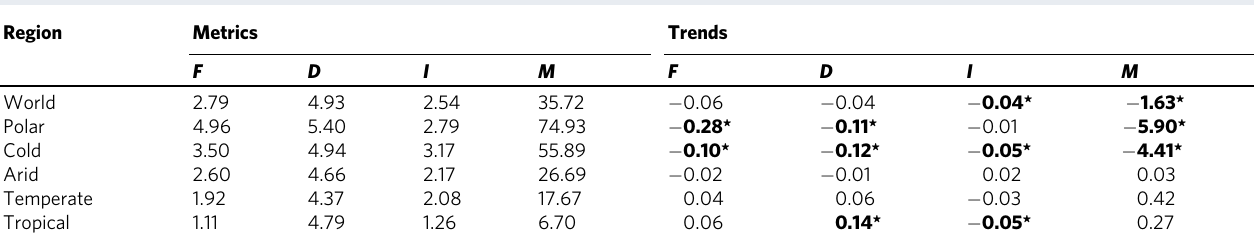
Table 1 TEE metrics and their temporal trends for all identi fi ed temperature extreme events (TEEs) in the world and in KG climate